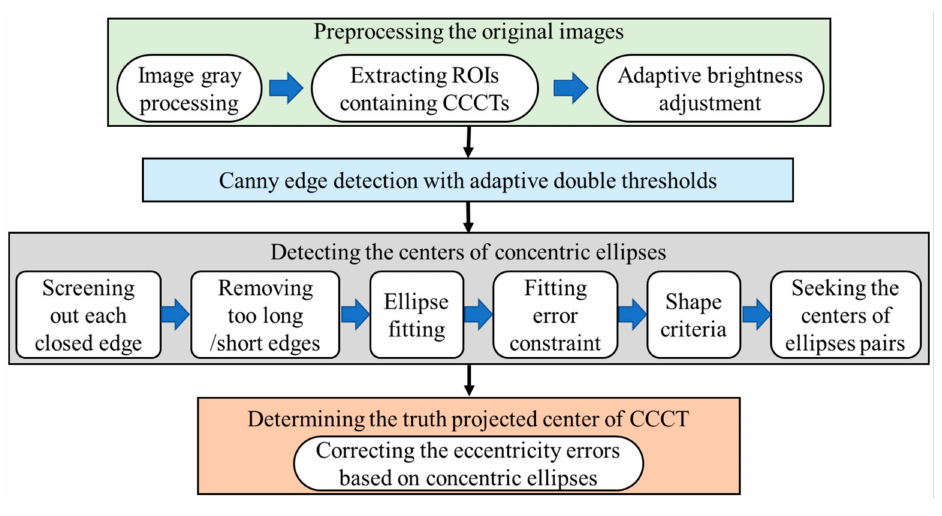
Figure 6. The workflow to locate the